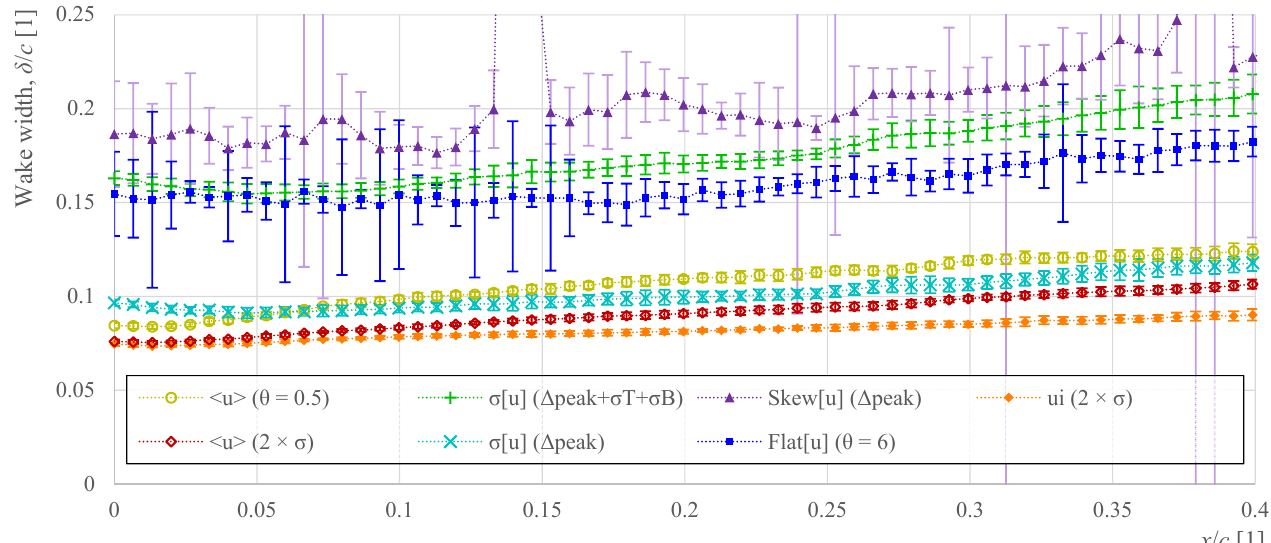
Figure 12. Comparison of the discussed definitions of wake width past the airfoil NACA 64-618 at zero angle of attack. Horizontal axis is the distance past trailing edge; all lengths are normalized by the airfoil chord. Golden circles: the distance of points, where average velocity deficit crosses half (threshold θ = 0.5) the maximum velocity deficit. Maroon diamonds: twice the thickness σ of the Gauss function fitted to the average velocity profile. Orange diamonds: the average of wake widths fitted to each snapshot. Cyan Xs: the distance of double-Gauss peaks fitted to the profile of standard deviation of stream-wise velocity. Green crosses: distance of mentioned peaks plus the thicknesses of those peaks in the profile of standard deviation of stream-wise velocity. Violet triangles: distance of double-Gauss peaks fitted to the profile of stream-wise velocity skewness (third statistical moment). Blue rectangles: distance of points, where the stream-wise velocity flatness reaches the threshold θ = 6, i.e., 2 × 3, the Gauss reference value.